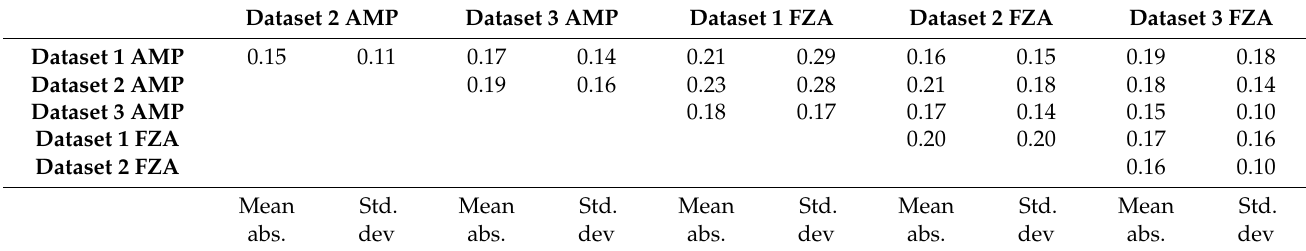
Figure 7. Untextured photogrammetric meshes from dataset 4, (from left to right) AMP, FZA, P4D, ARP, VCM.